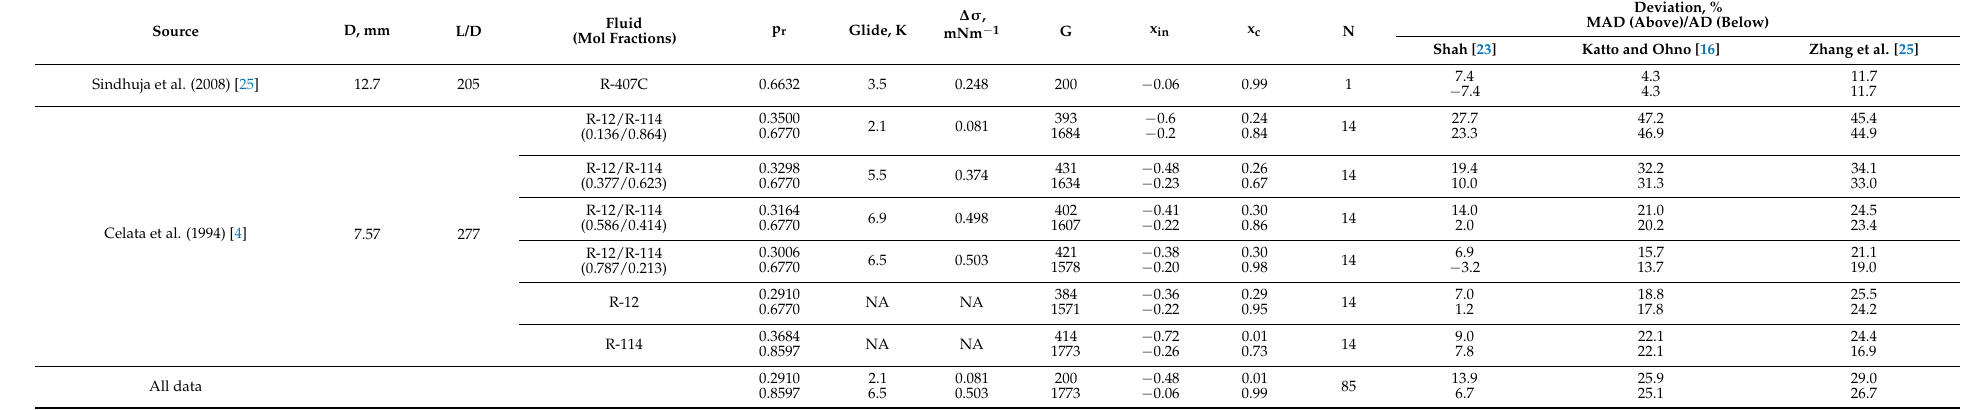
Table 1. Results of comparison of data for CHF in tubes with some correlations. All tubes are vertical, and flow is upward.